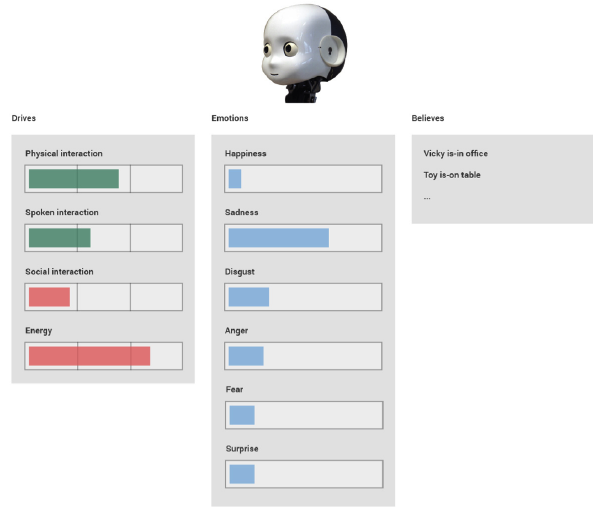
Figure 5: H5W_Alpha’s internal state is composed of the agent’s drives, emotions and beliefs. The same model is replicated for the representation of others as an attempt to have the robot at- tribute them with a limited theory of mind. The beliefs, emotions and drives of two agents can differ, although the robot is simulating their evolution by mirroring its